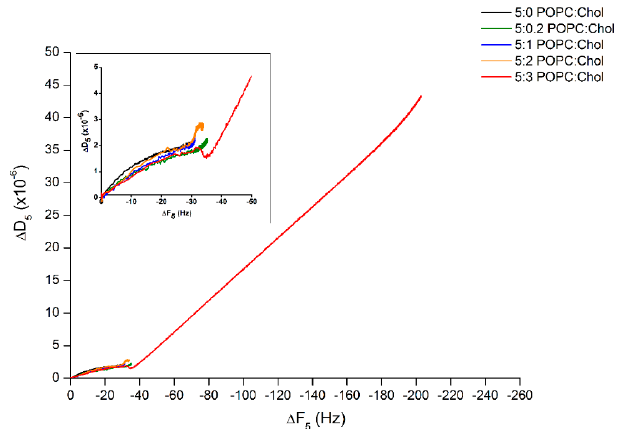
Figure 3. Analysis of the ∆ D– ∆ F plot of Cyt2Aa2 protein binding on the lipid bilayers with different levels of cholesterol content. The frequency and dissipation values of Figure 2 were plotted together in order to correlate the deposited mass and viscosity at each time point of protein binding. The behavior of protein–lipid binding was considered according to the direction of plots. Inlet depicts the blow up of the behavior of lipid binding until reaching the saturated state.